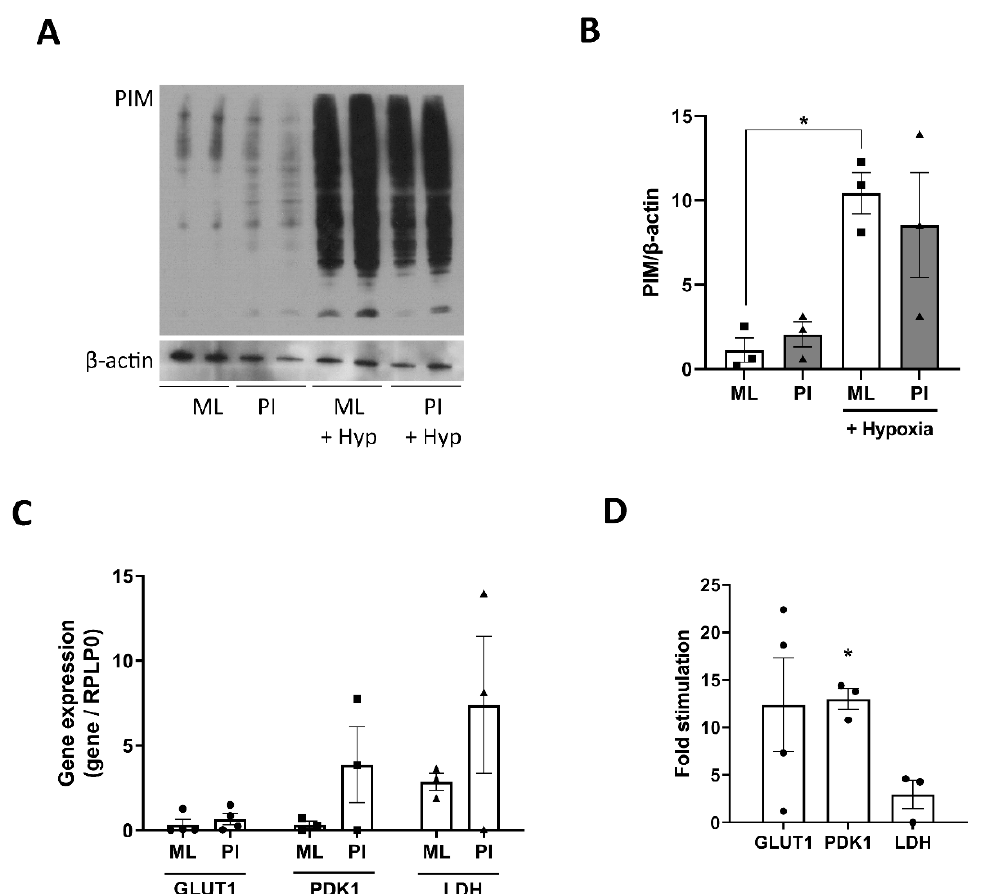
Figure 6. Pseudoislets show upregulation of some hypoxic markers. MIN6 cells (passage 26–30) were cultured in either standard cell culture plates (ML) or in un-coated Petri-dishes (PI) for 5 days. For assessment of hypoxia, ML and PI were cultured either under normoxia or hypoxic (1% O 2 ) for the final 24 h of culture. ( A ) Hypoxia was assessed by Western blotting for PIM adjuncts and expressed relative to β -actin. ( B , C ) Changes in gene expression was determined using real-time RT-PCR and expression corrected for RPLP0. Results are expressed as fold change relative to ML ( B ) or as gene of interest: RPLP0 ratio ( C ), or as stimulation index ( D ). n = 3. * p < 0.05 using an unpaired t ‐ test.